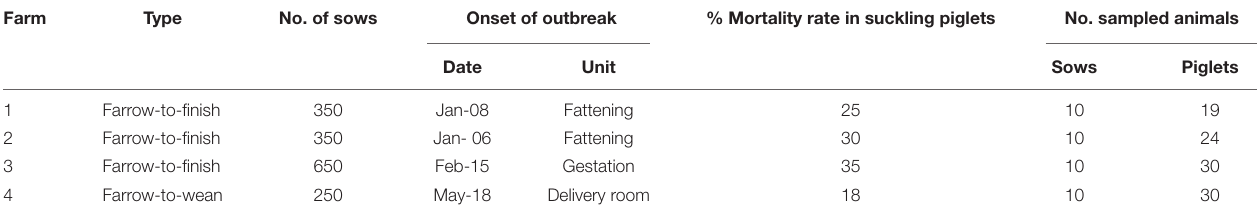
TABLE 1 | Farm production type, onset of outbreak, mortality rate, and animals enrolled in the longitudinal study. Farm Type No. of sows Onset of outbreak % Mortality rate in suckling piglets No. sampled